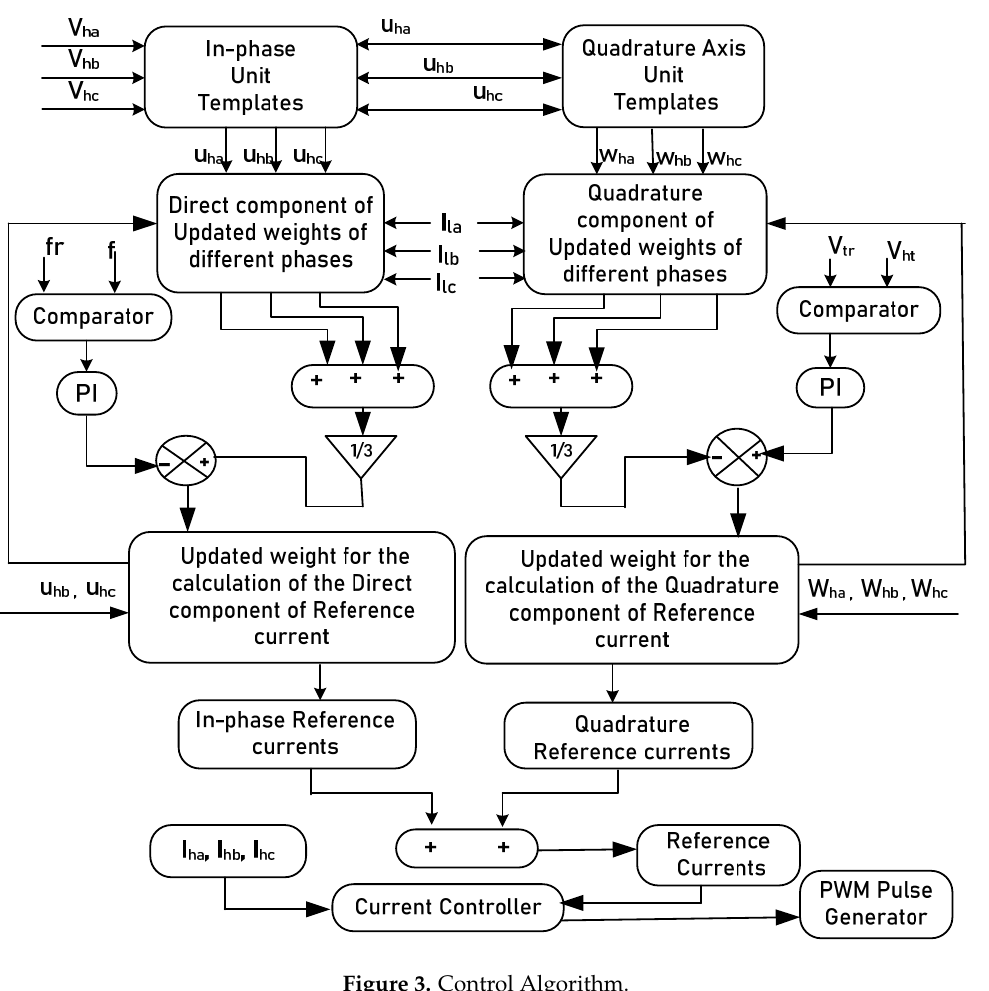
Figure 3. Control Algorithm.